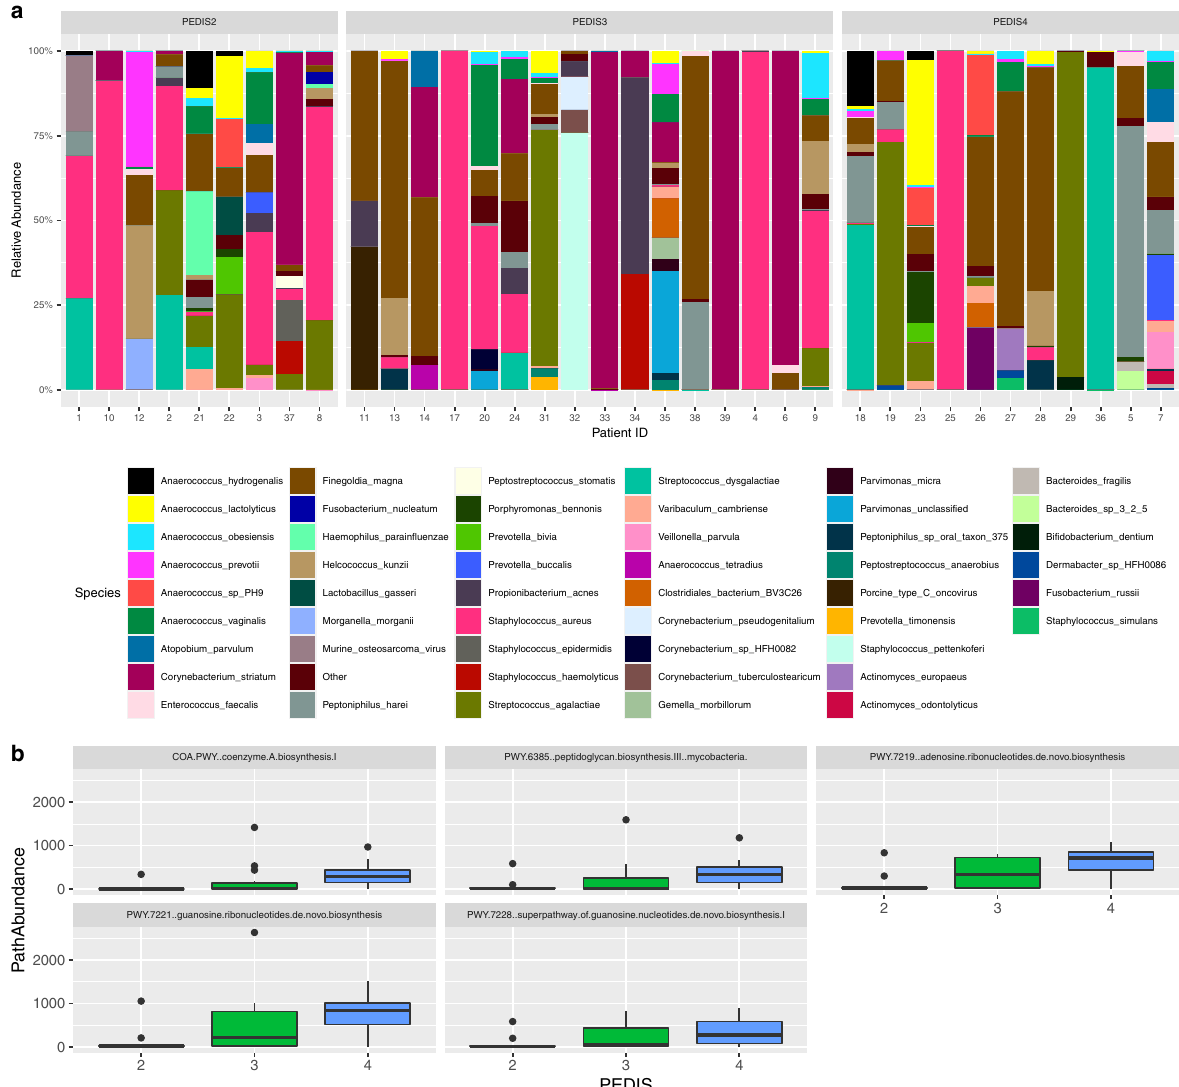
Fig. 1 Analysis of metagenomic shotgun sequencing data using Humann2. a Bar chart representing the 30 most highly abundant species (%) for 36 individuals with DFIs grouped by infection severity (PEDIS). Each bar represents individual species level identi fi cation. b Boxplots identifying metabolic pathways which are signi fi cantly different in abundance between infection severity groups (LDA score >2 ( p < K14192 (FC = − 14.21) and K20338 (FC = − 13.26) (Table 1, Supplementary Fig. 4, and Supplementary data 8).